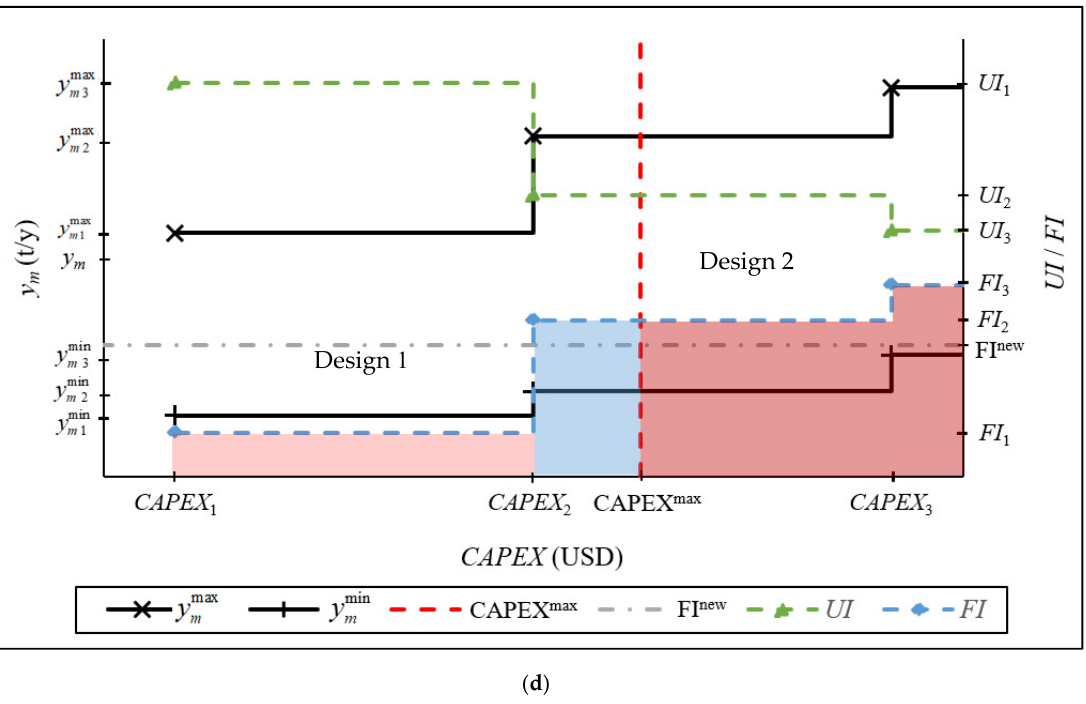
Figure 2. ( a ) FORA for a generic process. ( b ) FORA with y new m within the CAPEX max constraints. ( c ) FORA with y new m exceeding the CAPEX max constraints. ( d ) FORA with FI new and CAPEX max constraints.